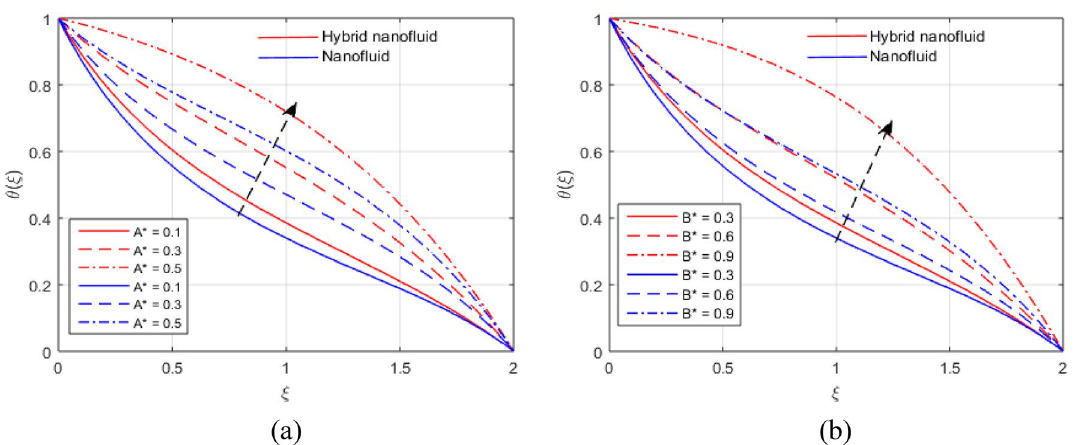
Figure 10. ( a , b ) Effect of A ∗ and B ∗ on θ(ξ)